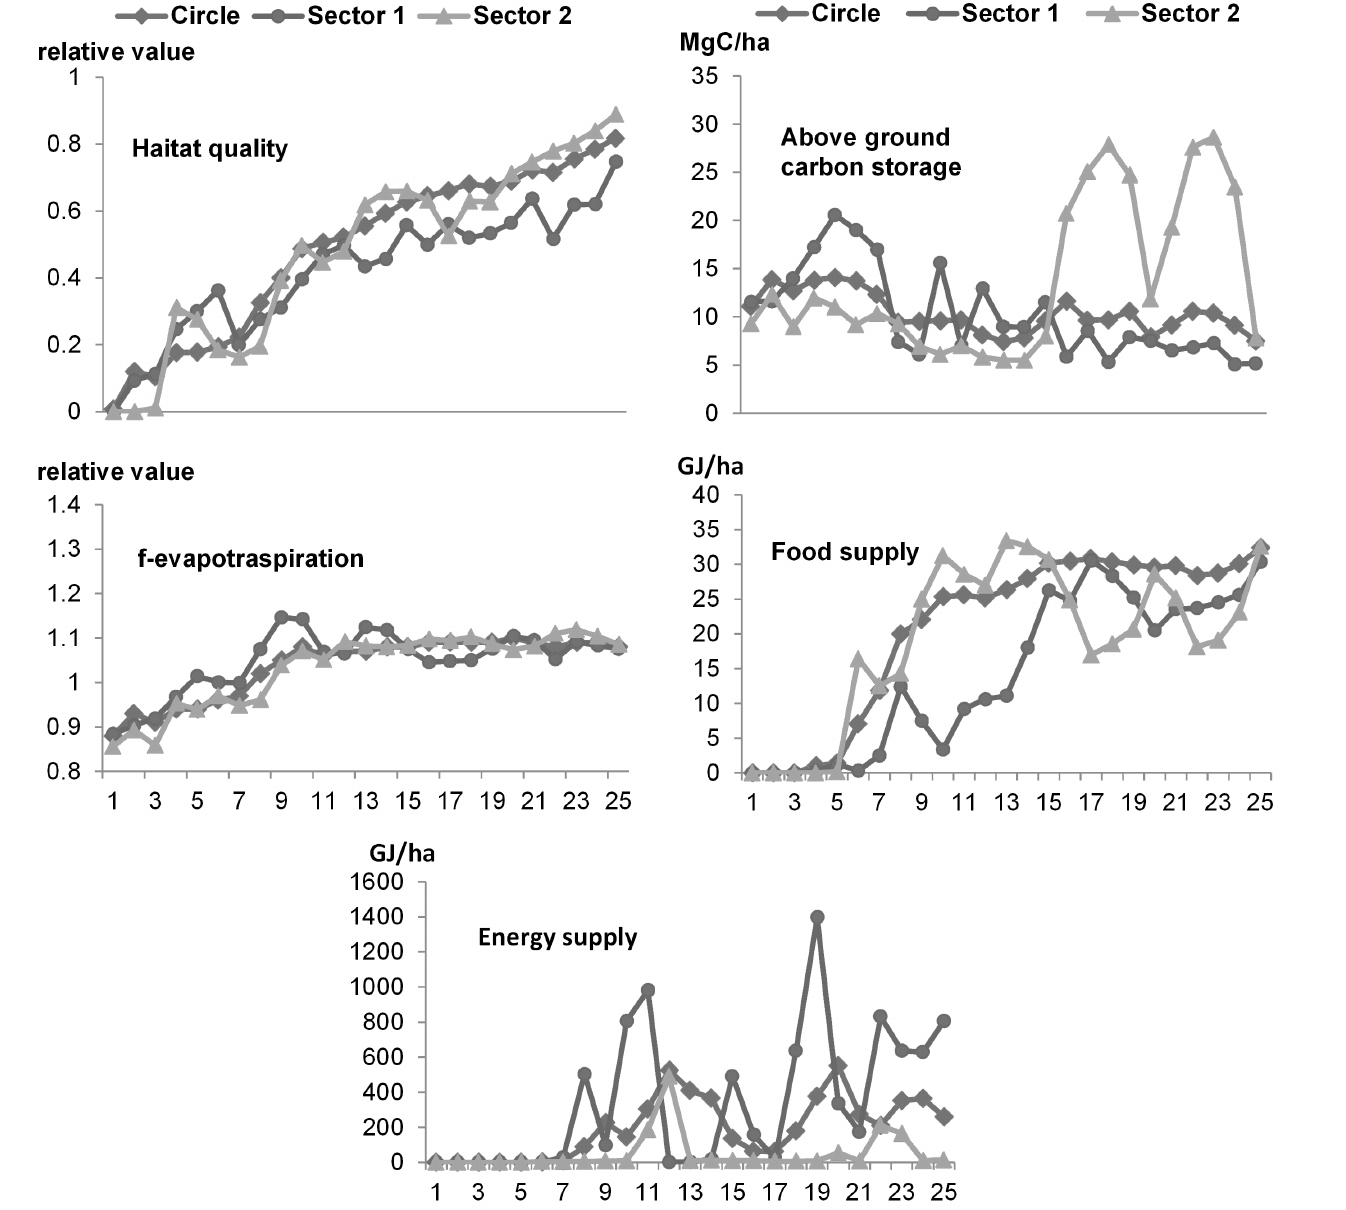
Figure 6: Gradients of the five ecosystem services in the circle and sector areas of the Leipzig urban-rural area. The X-axis is the distance in kilometers from the city center of Leipzig. The Y-axis is the average ecosystem service value of the associated concentric ring or concentric sector ring of the circle or sectors (food supply and energy supply are adapted from Kroll et al.,